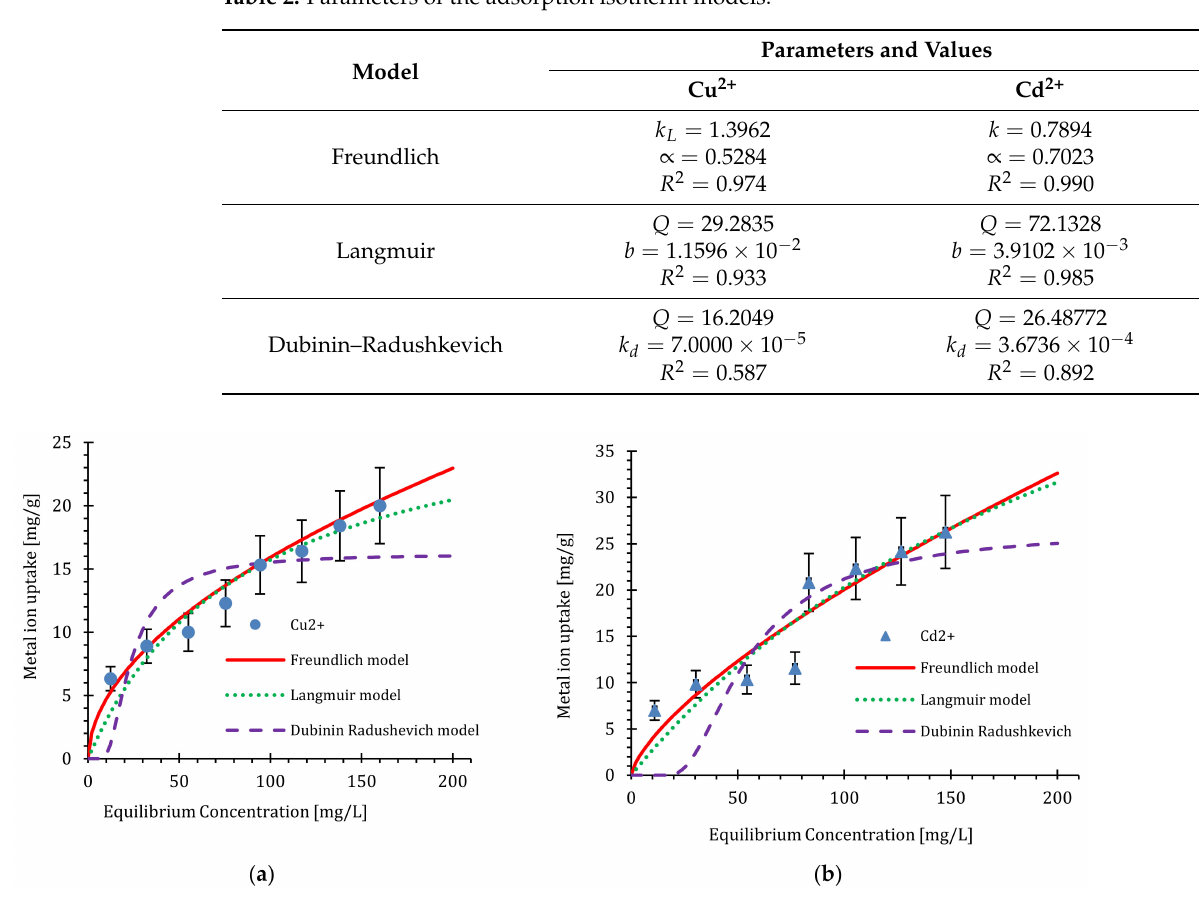
Figure 7. The Freundlich, Langmuir, and DR models’ fit for the adsorption equilibrium of ( a ) Cu 2+ and ( b ) Cd 2+ using the nanosilica (mass of adsorbent is 0.1 g, volume of solution is 50 mL, temperature is 25 ◦ C, equilibrium time is 72 h, and confidence limit is